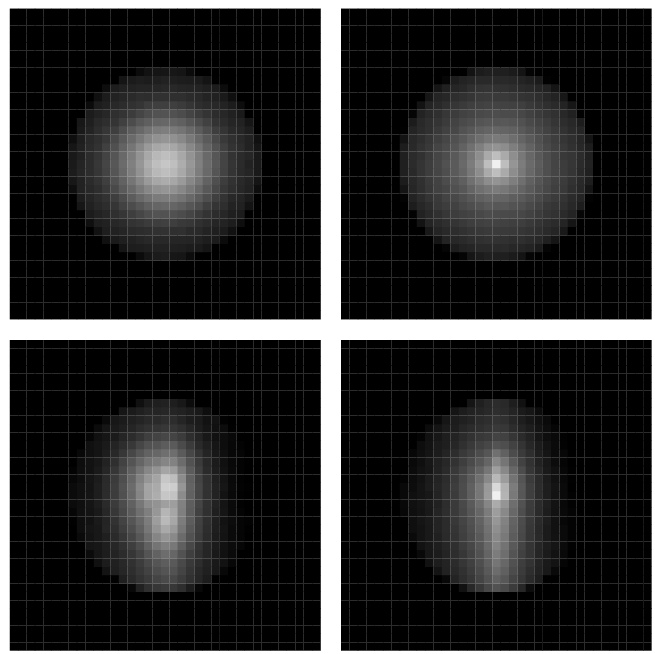
Figure 2 . The average of 100k jet images drawn from the CMS sample (37 (cid:2) 37 pixels spanning (cid:1) (cid:17) = (cid:1) (cid:30) = 3 : 2). The grayscale intensity corresponds to the total p T in each pixel. Upper: no preprocessing besides centering. Lower: with full preprocessing. Left: top jets. Right: QCD